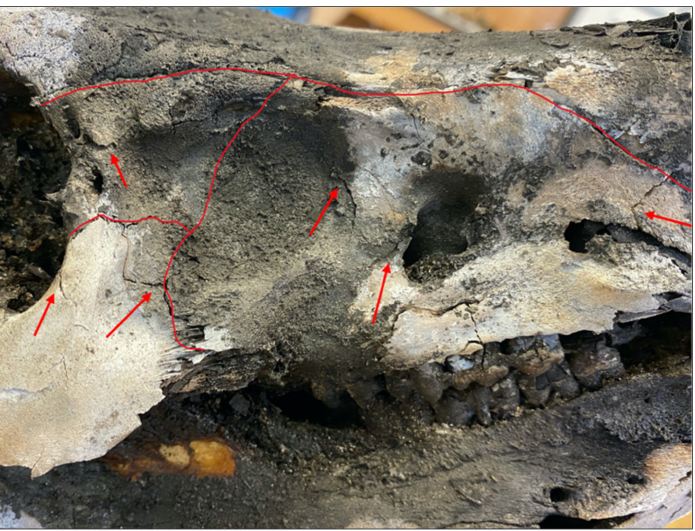
Figure 7. Red lines denote cranial sutures. Red arrows point out thermal fractures originating and terminating within other sutures or